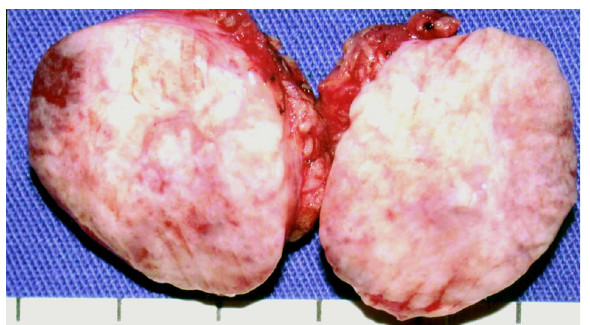
Figure 2 – Round, well-delimited, pale, fasciculate tumor, cov- ered by a smooth reddish capsule.